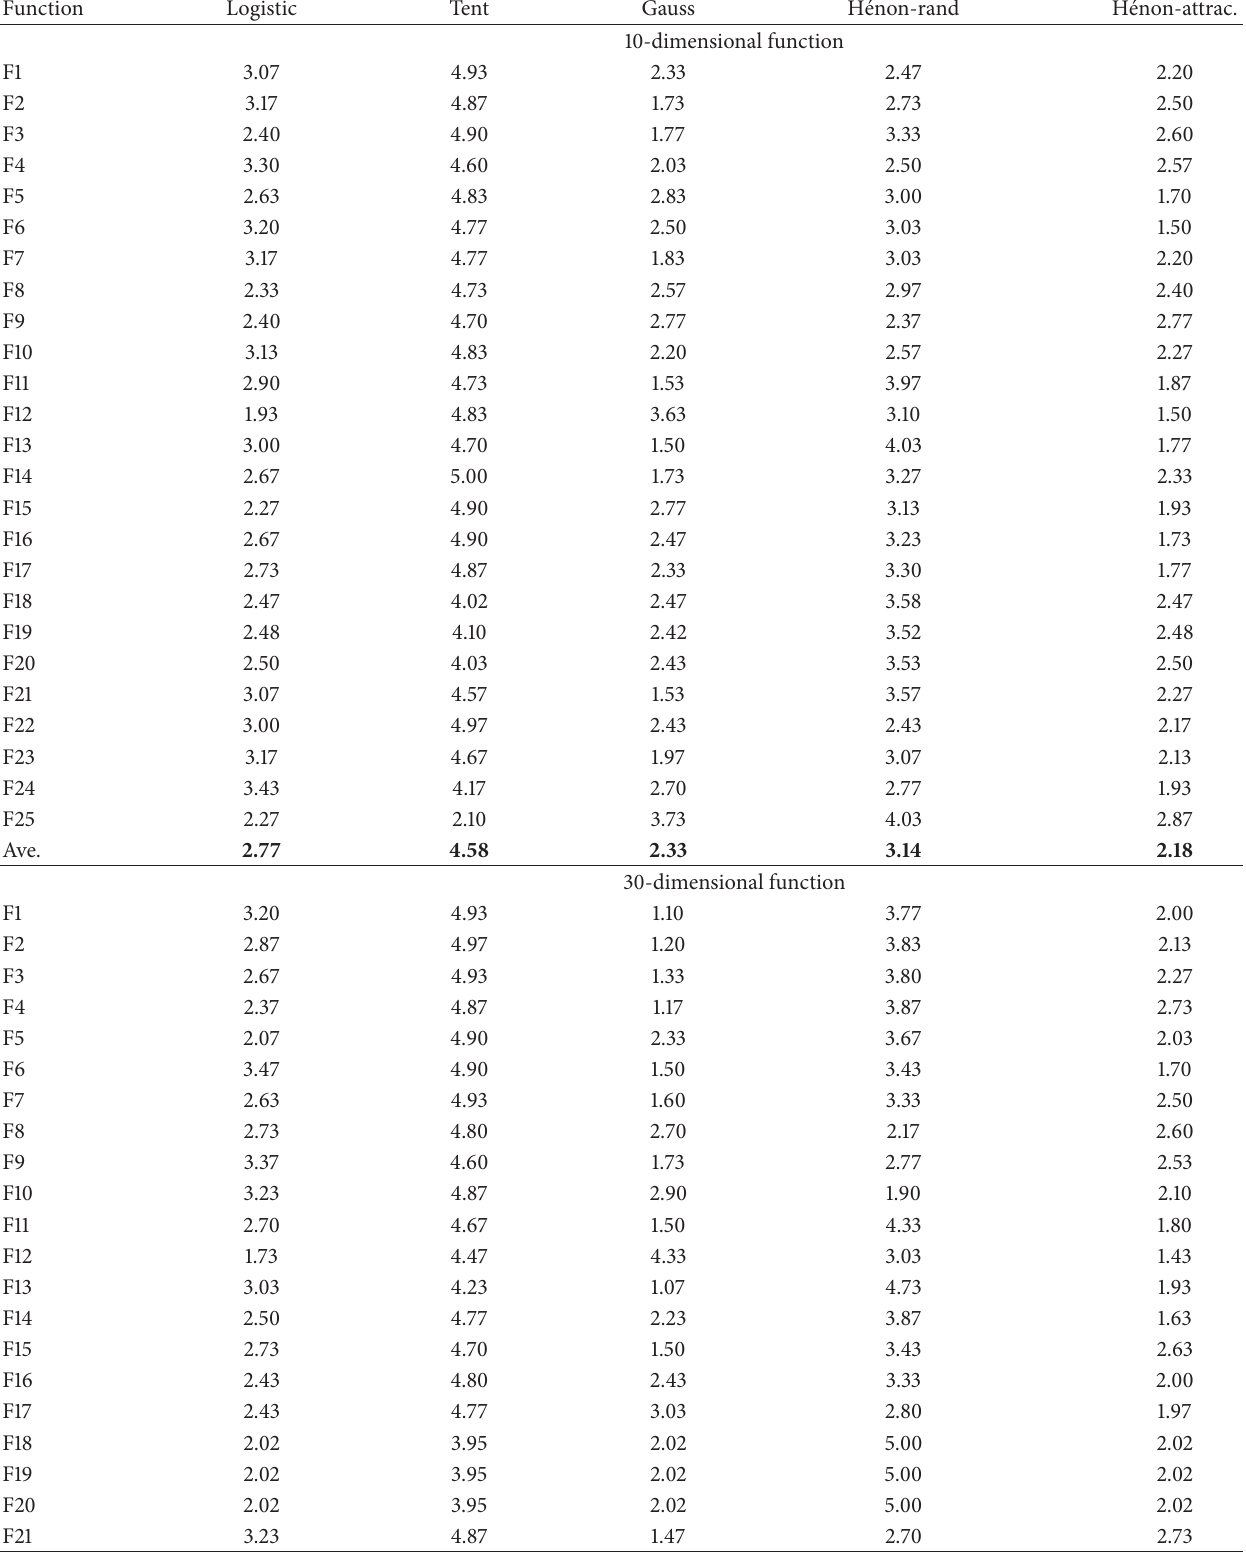
Table 7: Algorithms’ rank without DE by Friedman test for F1–F25 of 10D and 30D, respectively. The abbreviation meanings are in Table 2. Function Logistic Tent Gauss H´enon-rand H´enon-attrac. 10-dimensional